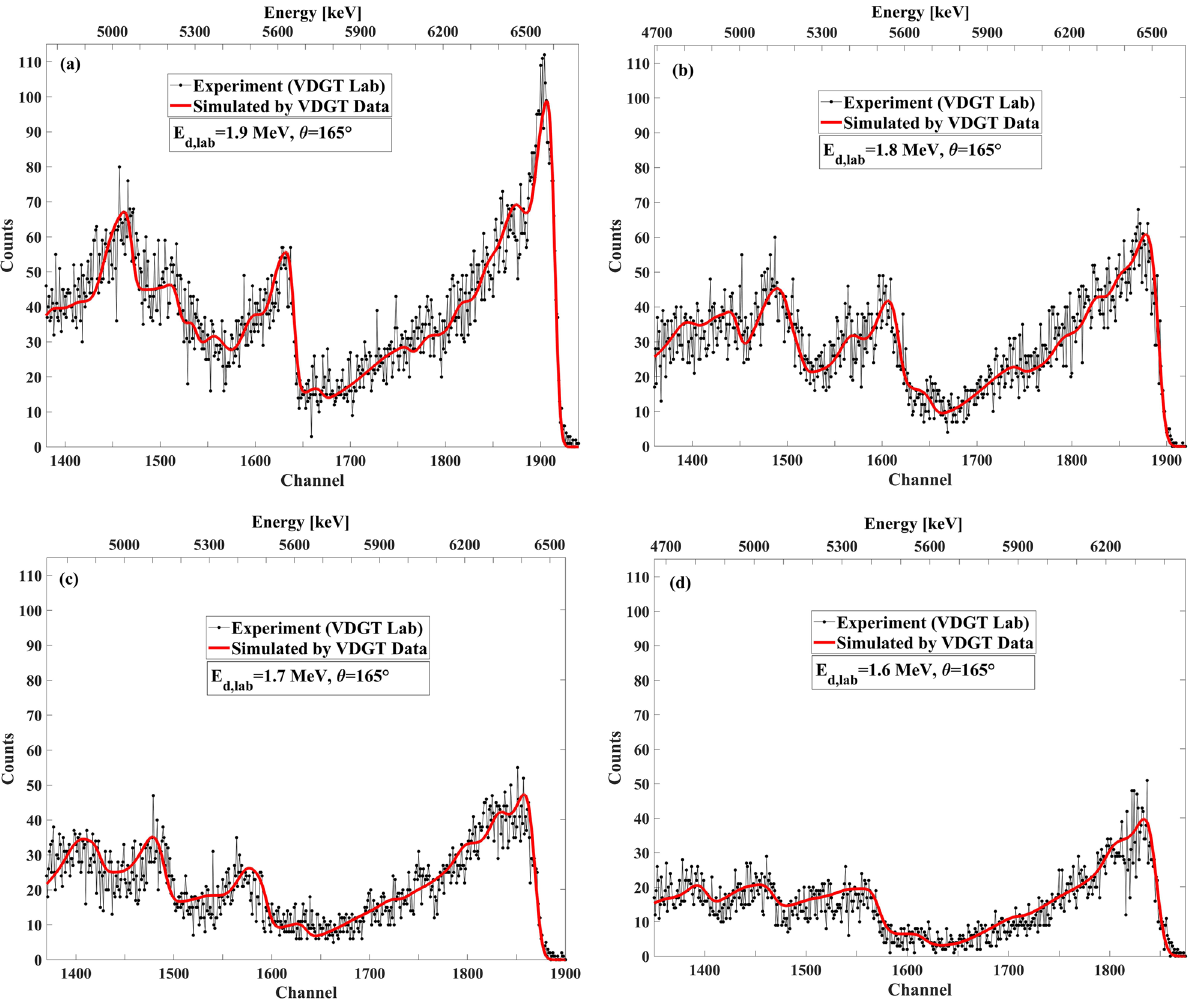
Figure 15. The benchmarking result at VDGT Lab in Tehran with measured VDGT data at 165° and different incident deuteron energies, ( a ) 1.9 MeV, ( b ) 1.8 MeV, ( c ) 1.7 MeV and ( d ) 1.6 straggling of the incident beam at these depths in the target, in this energy range the proposed cross section would not faithfully represent any fine structure. In order to differentiate between the cross sections measured by the thin targets and incarnated by the N = 20 Fourier series, from the values inferred from the benchmarking experiments, the two data sets are loaded separately into IBANDL.